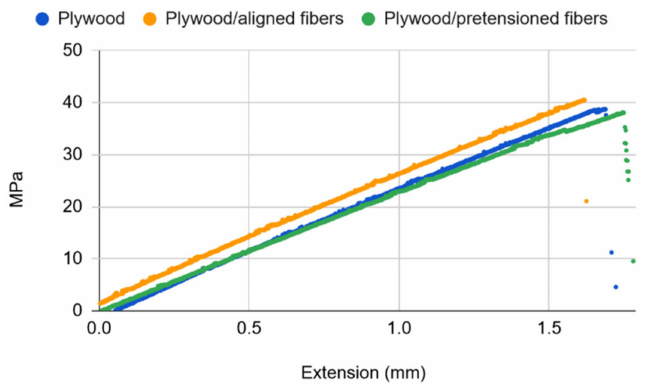
Figure 9. Typical stress-strain relations for plywood and basalt fiber-reinforced plywood at 150 ◦